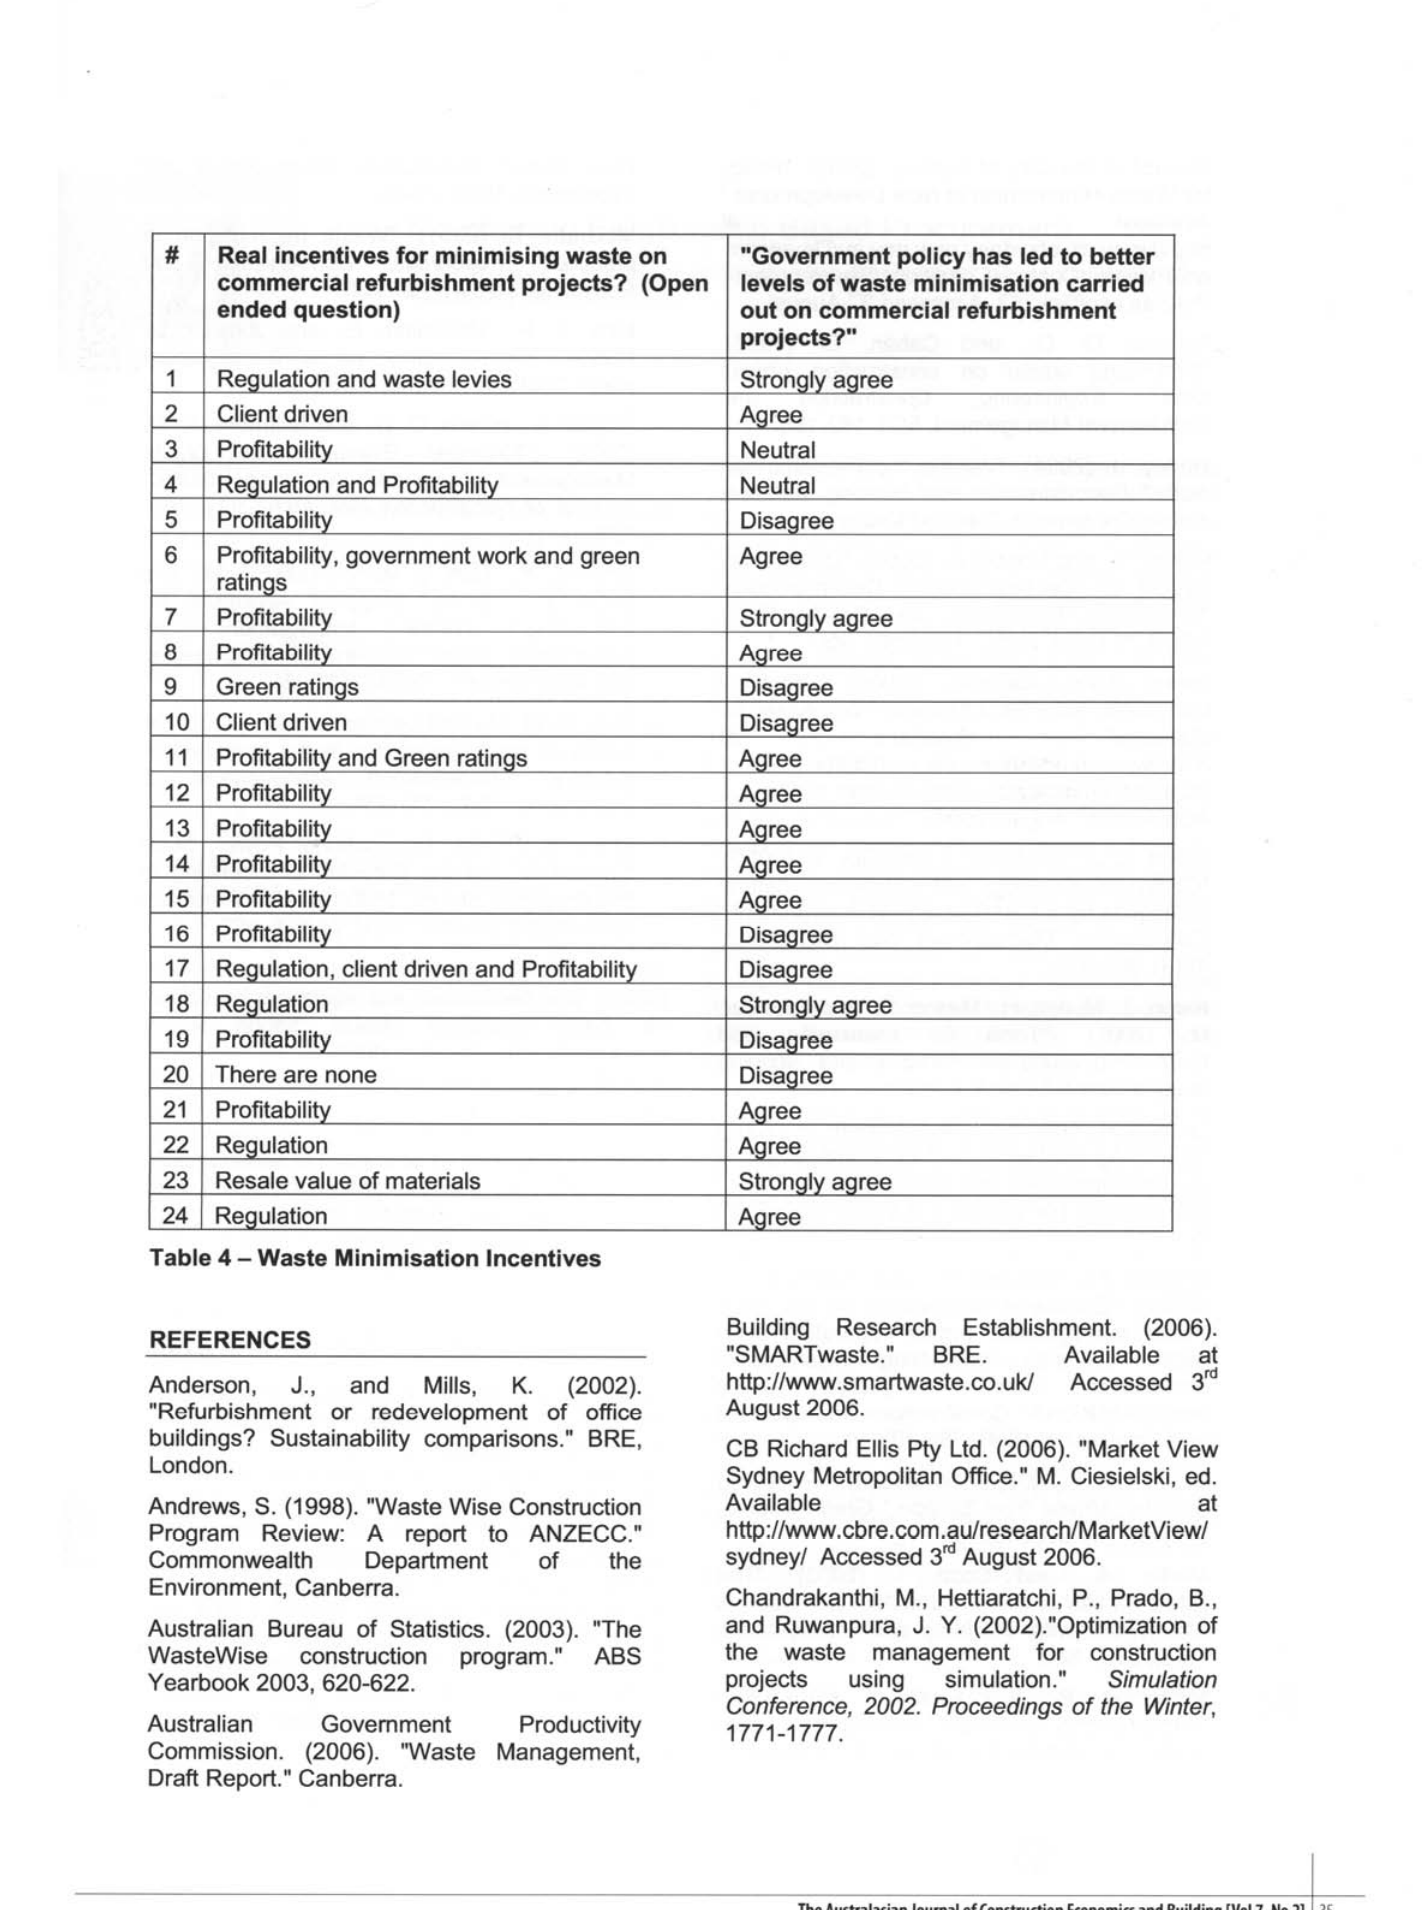
Table 4 - Waste Minimisation